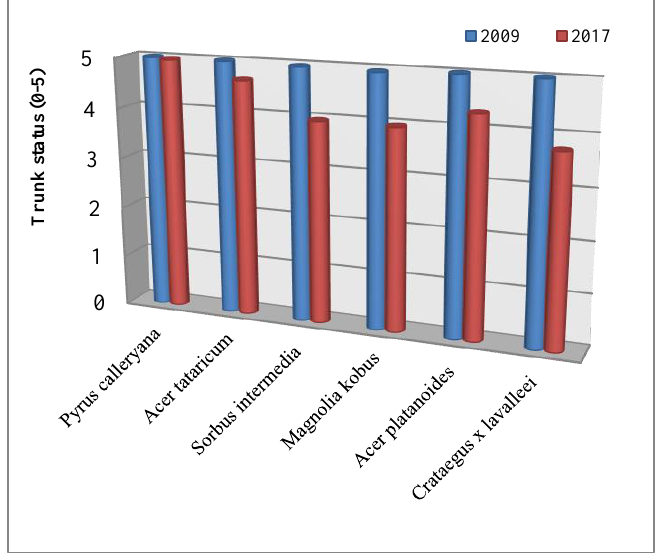
Figure 3. Trunk status of six tree taxa in streets of Debrecen in 2009 and 2017.